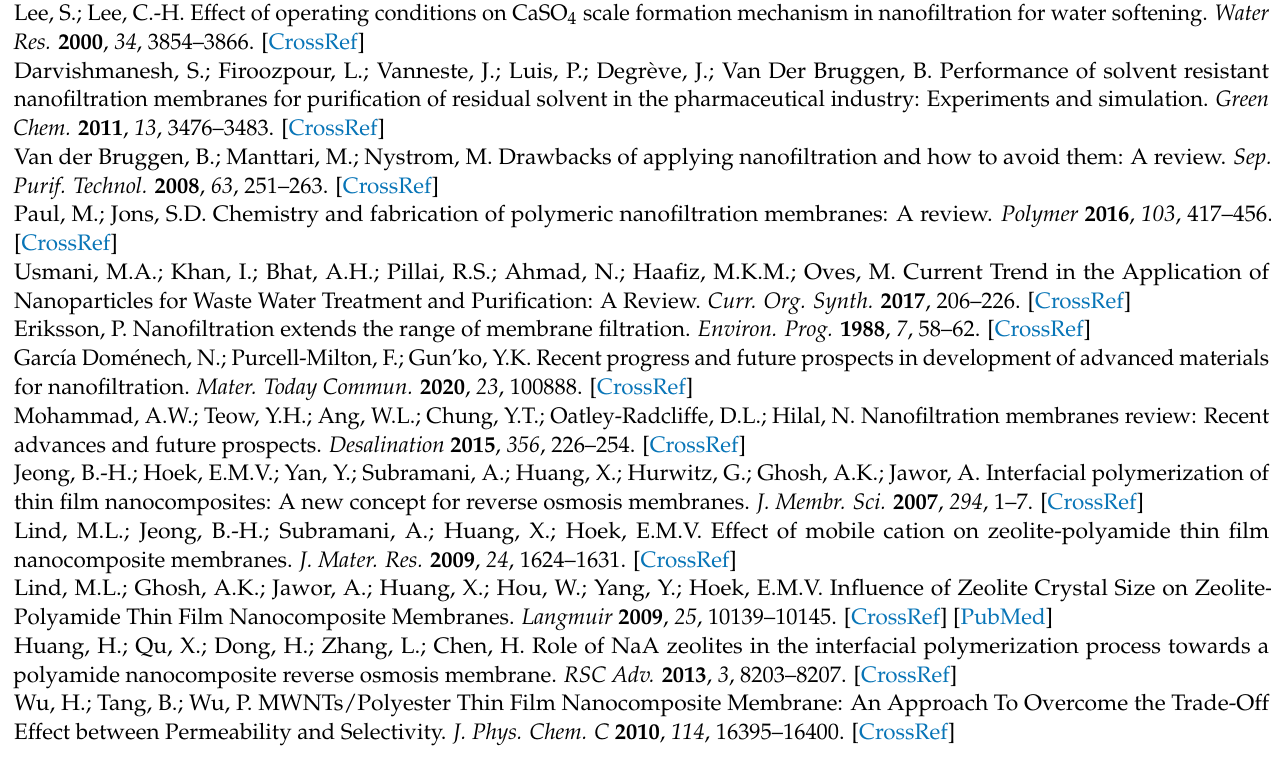
(red), BN-Water (black) and BN-Bulk (green); Table S3: Summary of BET surface area analysis data; Figure S12: SEM (a) and (b) top view of the membranes and (c) and (d) cross-section of BN-NMP; Figure S13: SEM (a) and (b) top view of the membranes and (c) and (d) cross-section of BN-IPA; Figure S14: SEM (A) and (B) top view of the membranes and (C) and (D) cross-section of BN-Water; Figure S15: Picture of BN membrane (a) before and (b) after filtration with Evans Blue; Table S4. Retention and thickness of the membranes made from BN exfoliated, BN-NMP-Mem, BN-IPA-Mem and BN-Water-Mem; Figure S16: UV-Vis spectra of the retention of 20 mL of Evans Blue (15 µ M) through BN mem-branes made from exfoliation in (a) NMP, (b) IPA,(c) Millipore water and (d) close up of the maximum absorbance peaks of the BN membranes from exfoliation in Millipore water; Table S5: Statistics from the retention of the membranes obtained with the different solvents, NMP, IPA and Millipore water; Figure S17: UV-Vis spectra of the retention of 20 mL of (a) Methyl Orange (50 µ m) and (b) Methylene Blue (27 µ m) through BN membranes exfoliated in Millipore water; Table S6: Statistics from the retention of the membranes obtained with Millipore water and tested with two dyes, Methyl Orange and Methylene Blue; Figure S18: BN membrane after filtration of (a) Methyl Orange and (b) Methylene